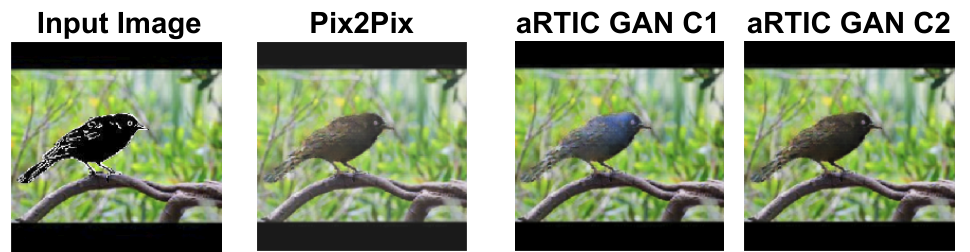
Figure 10. The supervision of the generation process is committed via the sketch, generating different poses and the species with the same caption.